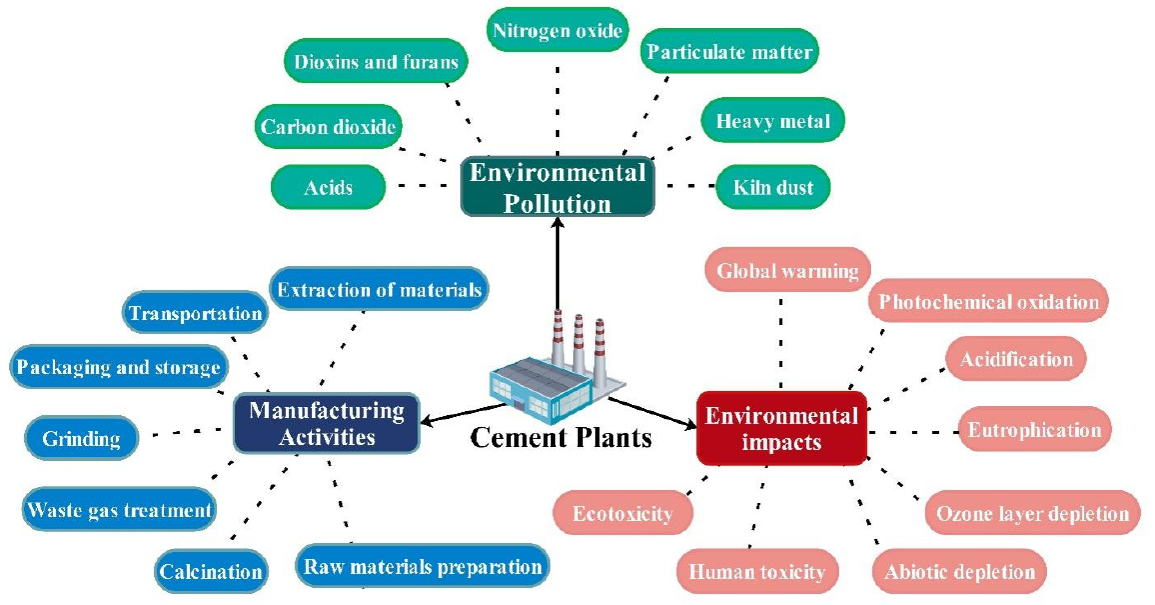
Figure 2. Potential resources of the pollution from the cement industrial zones.